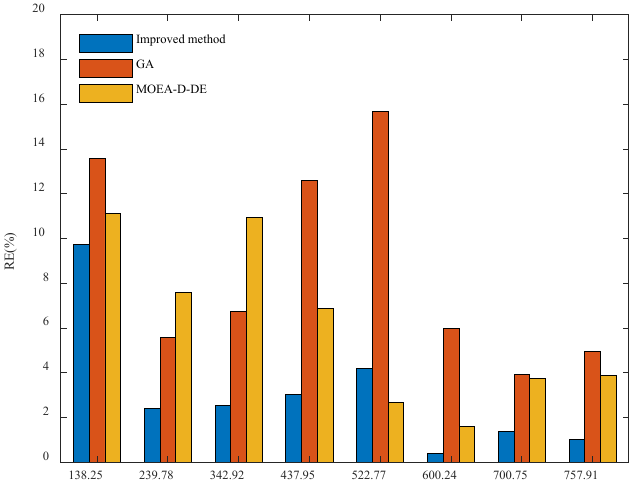
Figure 7. Comparison of the fertilization accuracies.